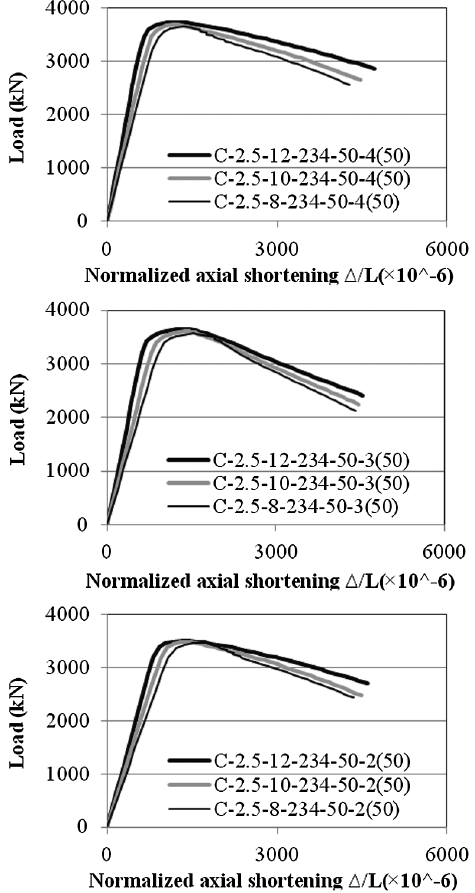
Fig. 12. Effect of diameter of bar stiffeners on ultimate axial load capacity